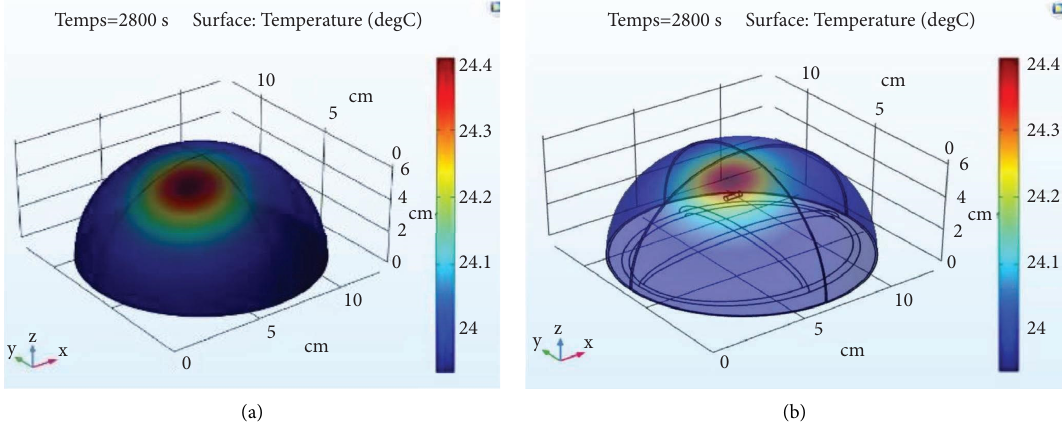
Figure 6: Image of breast phantom with LOQ tumor (a) Simplifed phantom model and (b) Approximated phantom model.